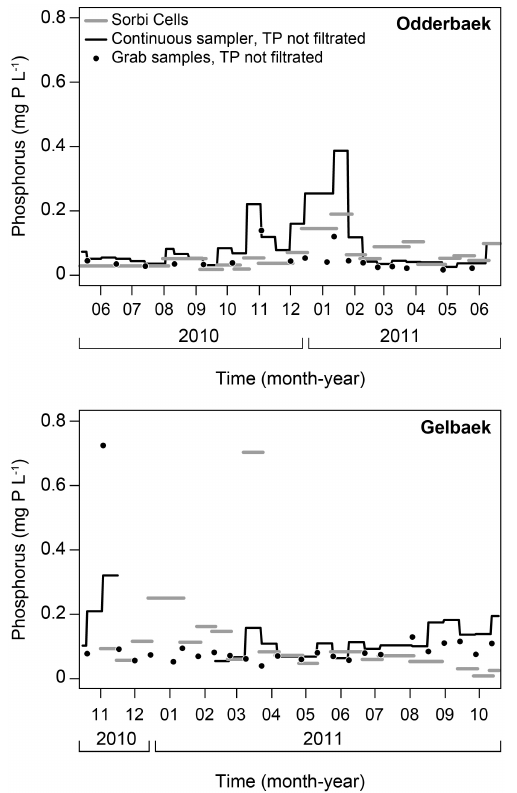
Figure 4. Phosphorus concentrations at Odderbaek and Gelbaek determined passive samplers, grab sampling and time-proportional sampler. The monitoring by the time-proportional sampler at Gel- baek was interrupted in winter because of freezing.